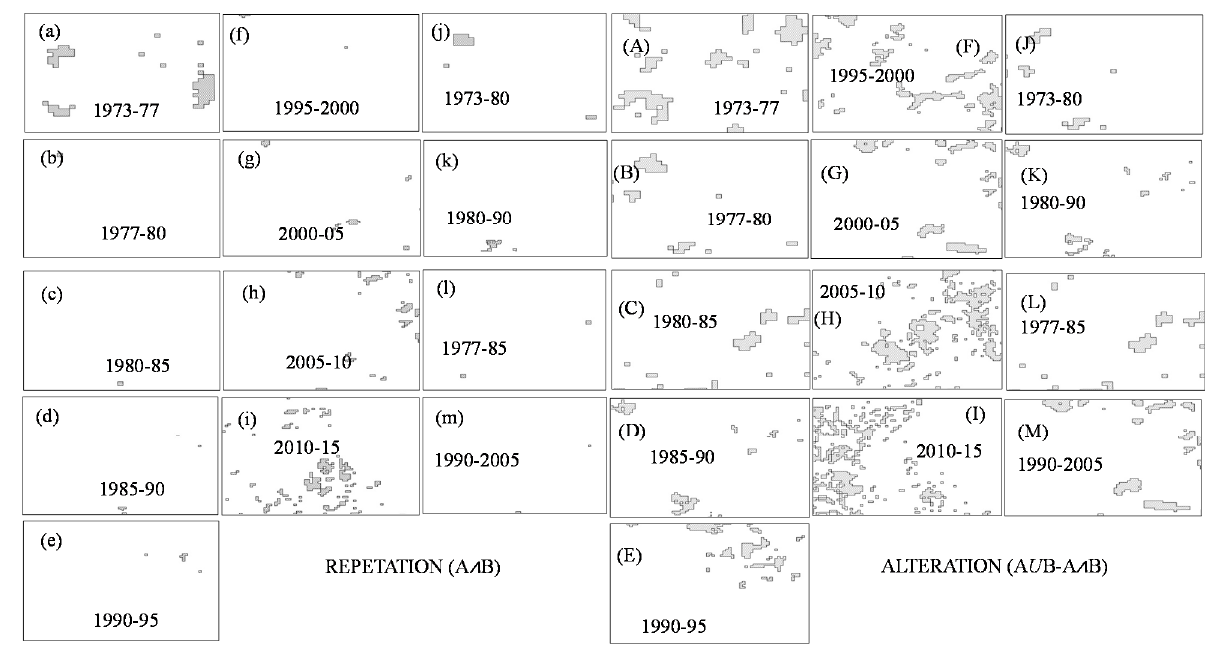
Figure 2. SFCC Landsat images for different time periods (LHS; a – j ) and the corresponding shifting cultivation patches identified from the NDVI change analysis (RHS; A – J ).